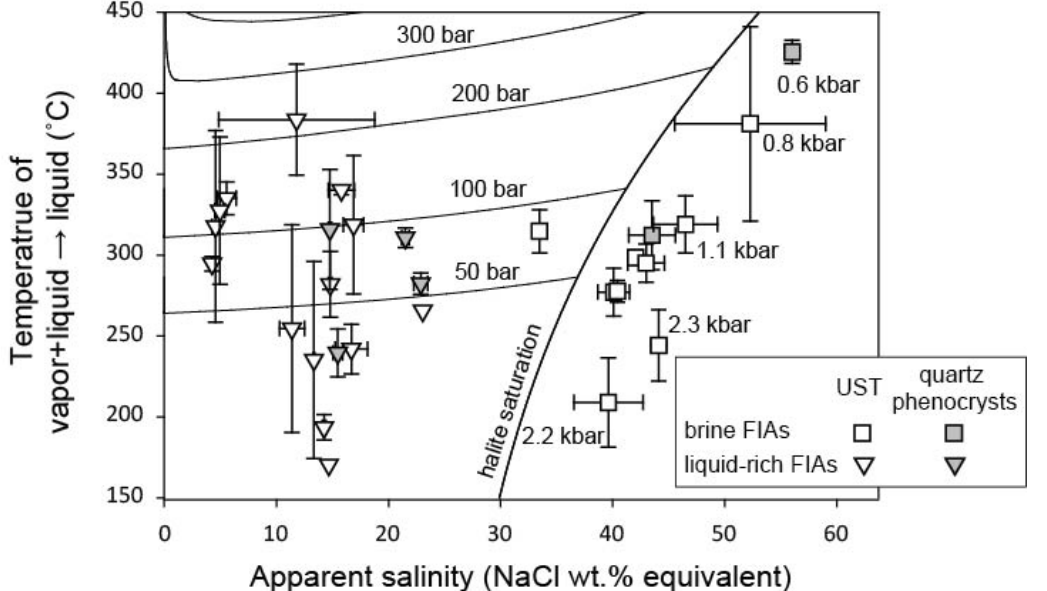
Figure 4. Plots of liquid-rich and brine inclusion assemblages showing apparent salinities (wt.% NaCl equivalent) and homogenization temperatures (°C) of vapor bubble + liquid into liquid. Isobaric and halite saturation curves were calculated from a model NaCl-H 2 O system [47]. Many of the brine inclusion assemblages plotted in the field of halite saturation (totally homogenized by salt dissolution) and brine pressure were calculated with NaCl liquidus [48]. FIAs hosted in the UST are expressed with empty symbols.